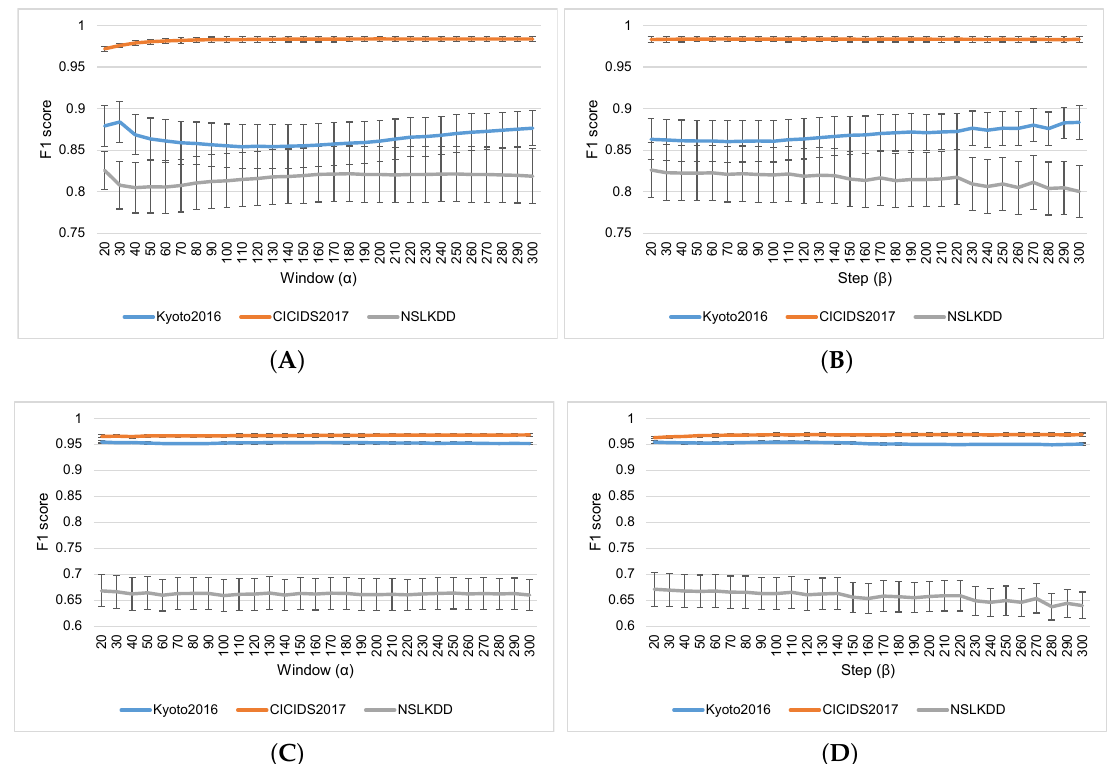
Figure 6. Average F1 scores ± SEM for all classification algorithms with different window and step sizes. ( A ) DWT features with α variation; ( B ) DWT features with β variation; ( C ) PCA features with α variation; ( D ) PCA features with β